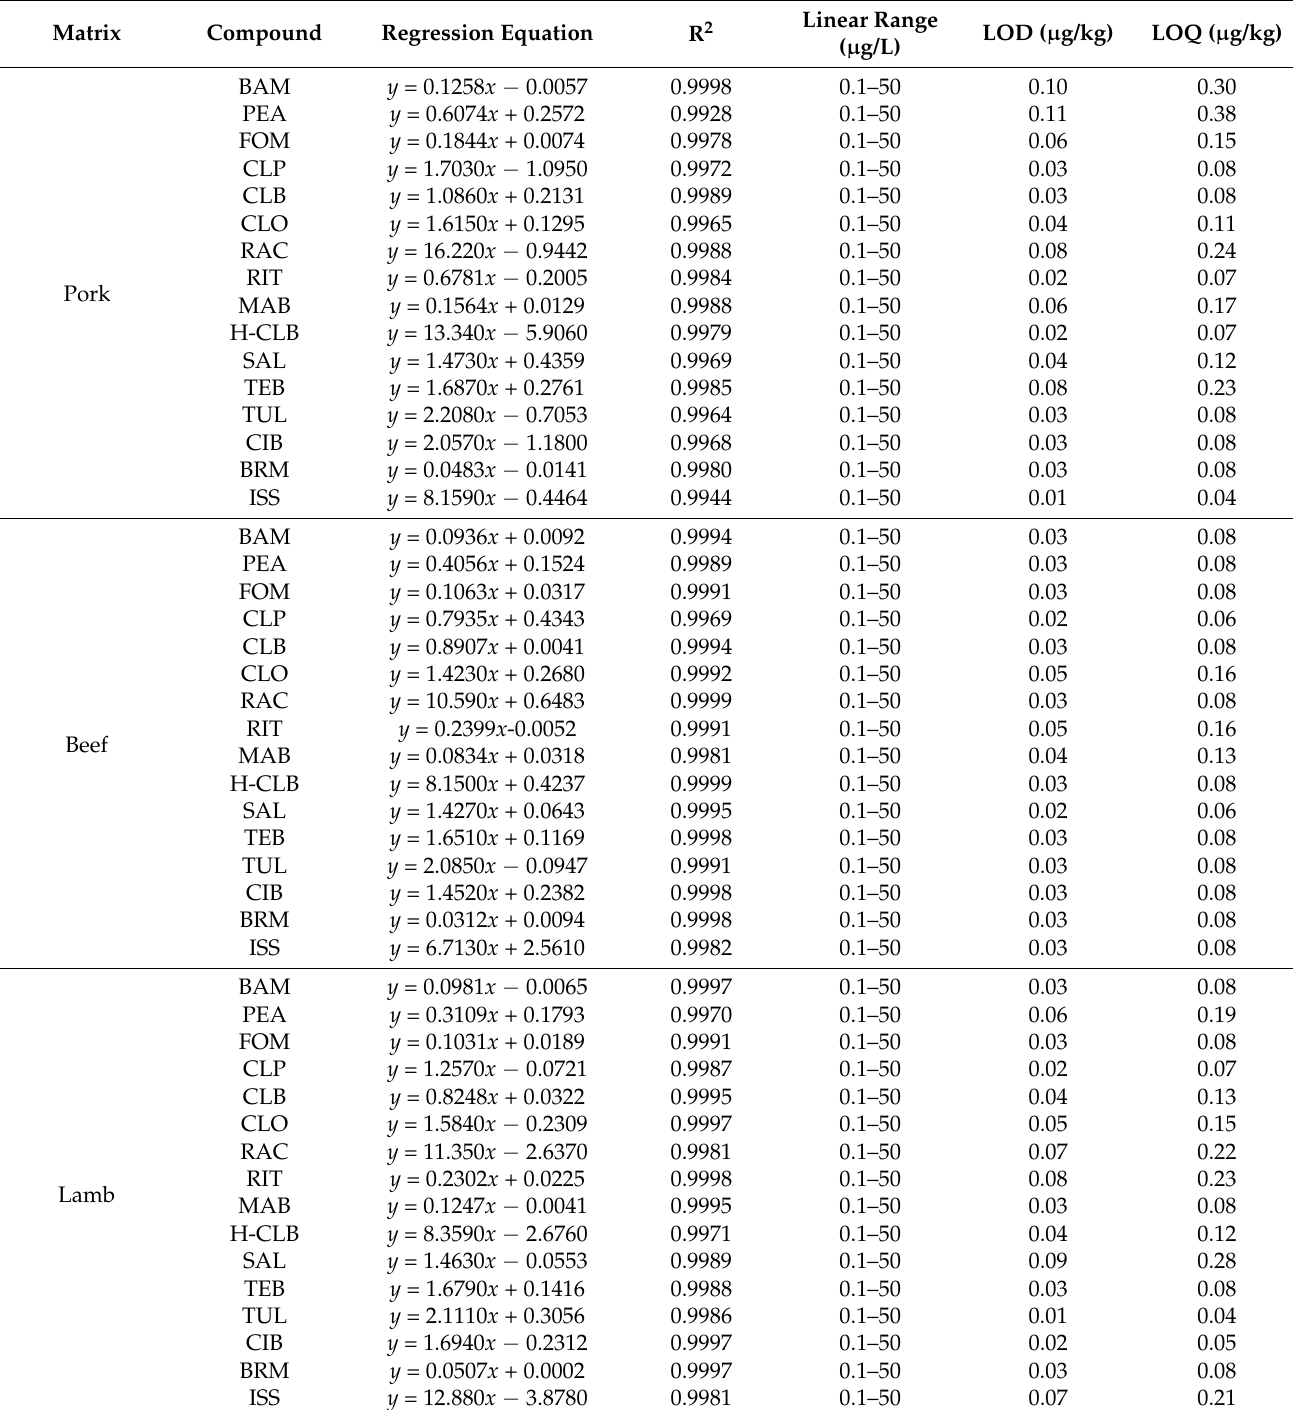
Table 5. Linear equations, LODs, and LOQs of sixteen β -agonists in livestock